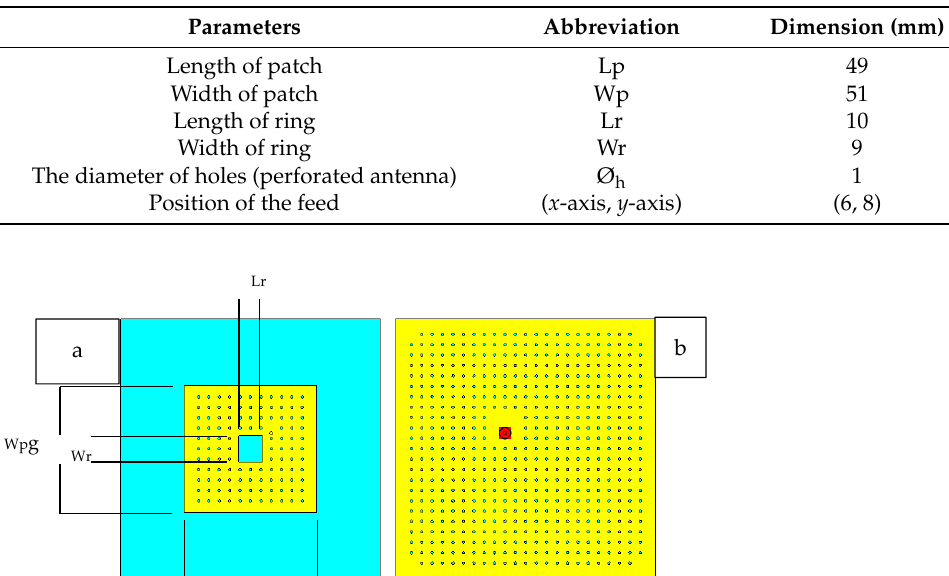
Figure 4. Front view ( a ) and back view ( b ) of the CST model of the non-perforated RRMPA. Table 3. Dimensions of non-perforated and perforated textile RRMPAs.